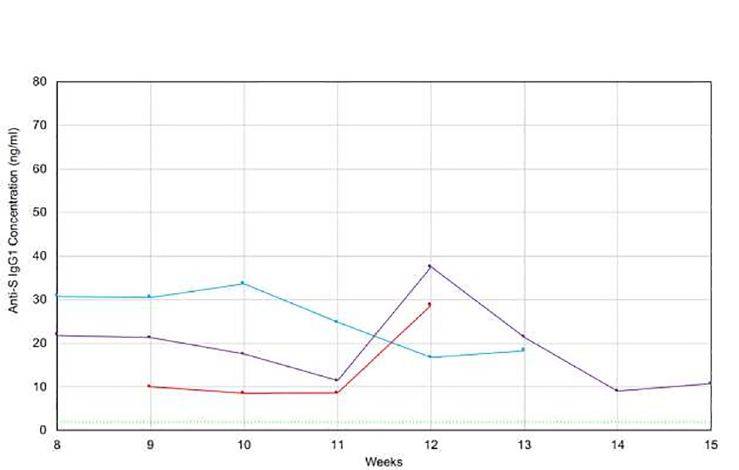
Fig 11. Longitudinal measurement of saliva anti-SARS-CoV-2 IgG levels in 3 recovered patients. X-axis: Time after initial onset of symptoms (in weeks). Y-axis: IgG levels measured in saliva.